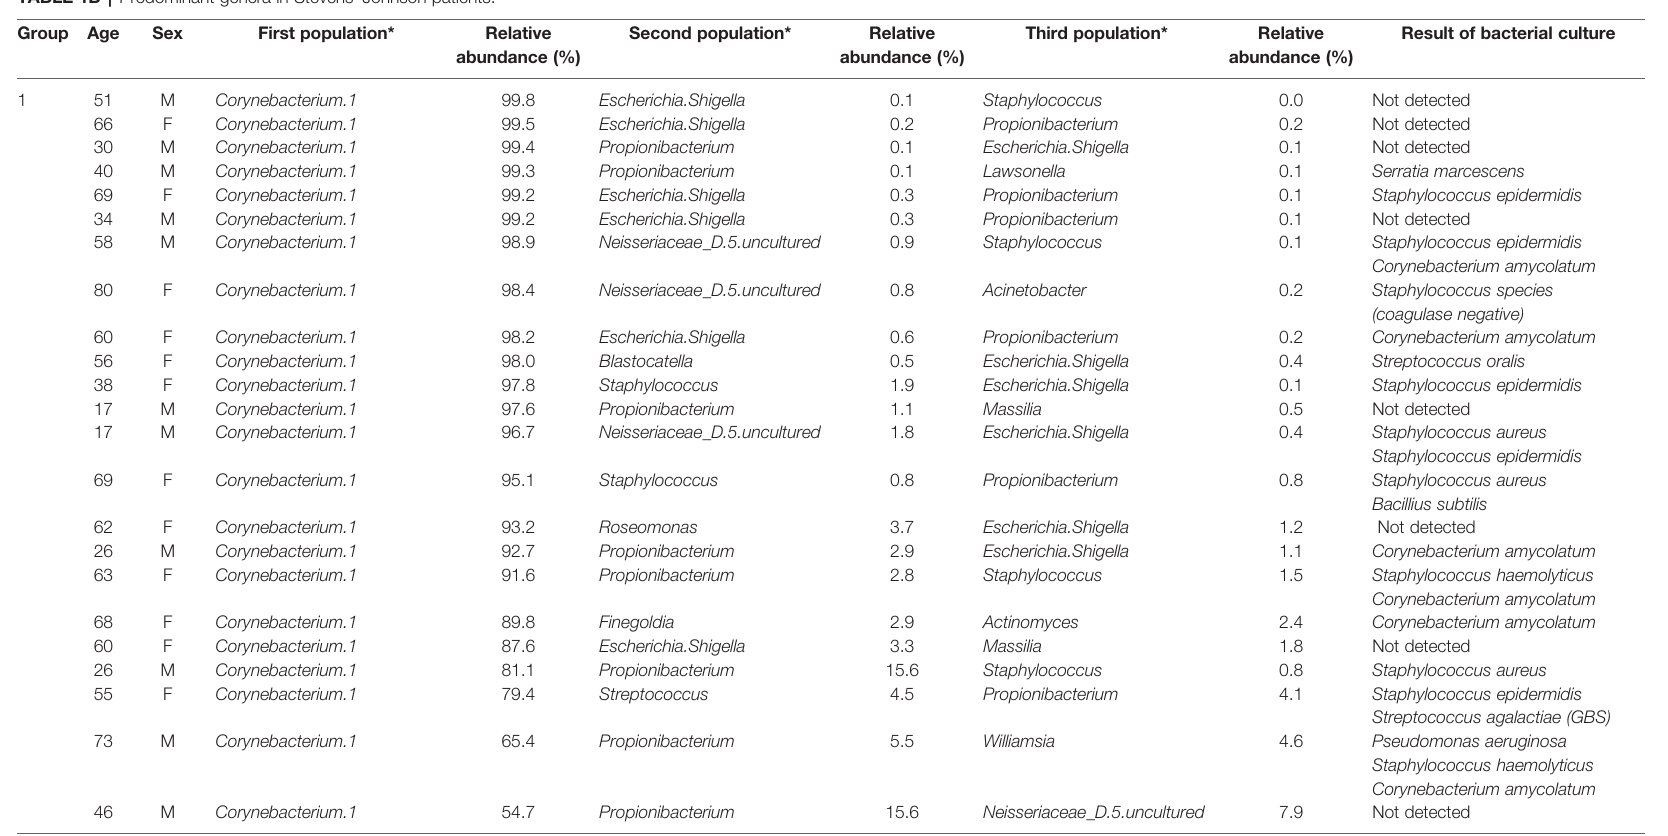
*Bacterial genera were ranked from those with high proportions. TABLE 1B | Predominant genera in Stevens – Johnson patients. Group